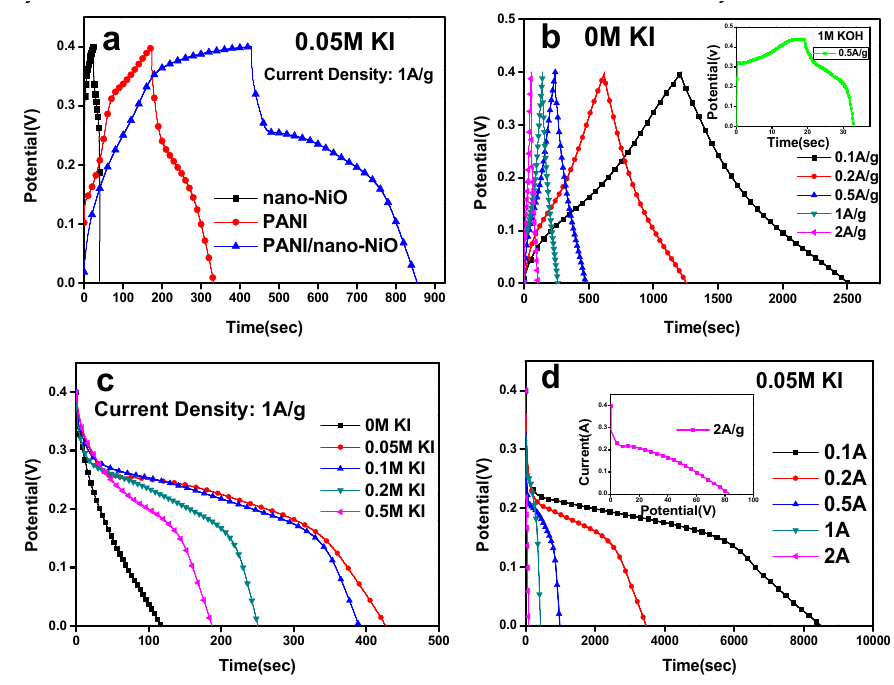
Figure 7. GCD curves in different current densities, electrolytes and concentration of KI. ( a ) 0.05 M KI, 1 A/g. ( b ) 0 M KI, 0.1–2 A/g. ( c ) 0–0.5 M KI, 1 A/g. ( d ) 0.05 M KI, 0.1–2 A/g.